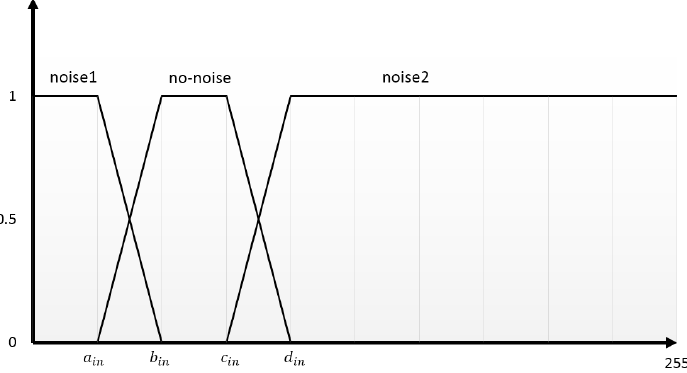
Figure 9. Repair of darker areas ( u * = 51).